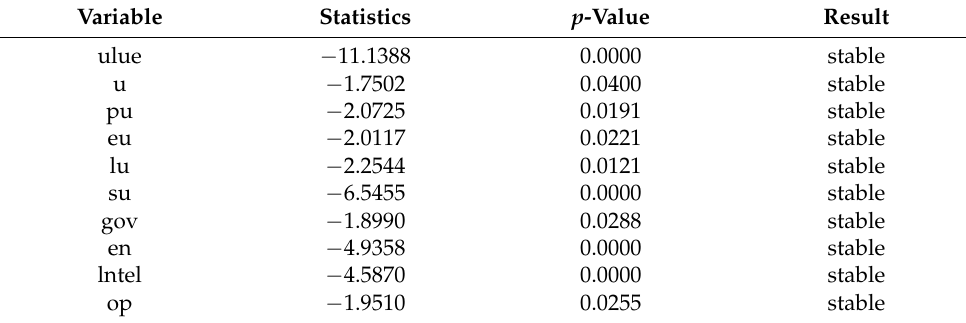
Table 4. Unit root test result.